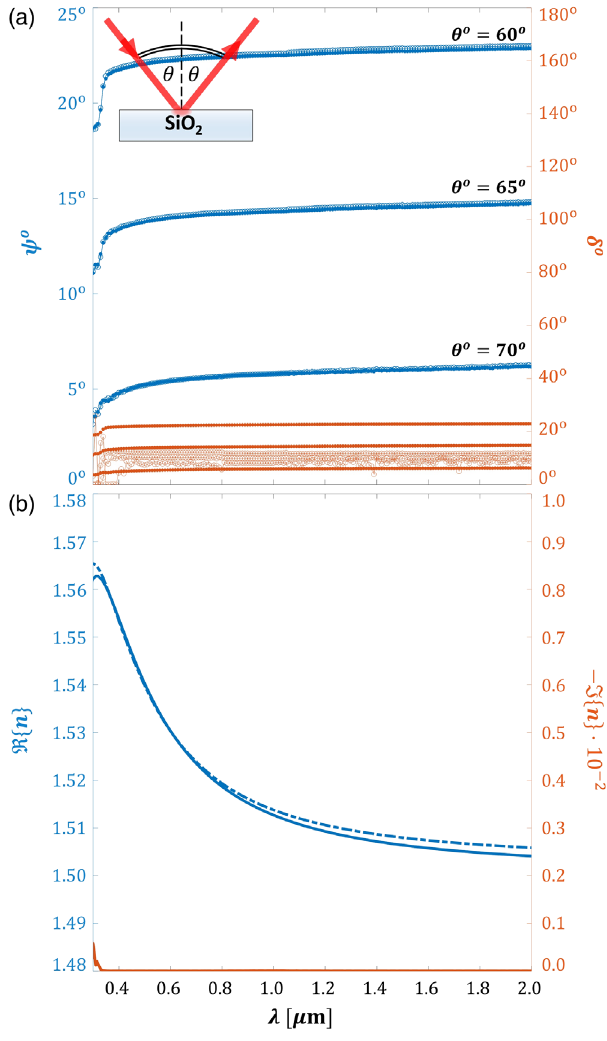
FIG. 5. Ellipsometry of chemically treated glass substrates. (a) Measured ellipsometry parameters ψ (blue, left axis) and δ (orange, right axis), for treated (hollow circles) and nontreated (dots) cover glass substrates as a function of illumination wave- length λ at three incidence angles θ (noted inset). (b) Real (blue, left axis) and imaginary (orange, right axis) parts of the refractive index n of the treated (dashed line) and nontreated (solid line) glass covers fitted from the measured data in (a). The change in n is smaller than 2 . 5 × 10 − 3 over the 300 nm – 2 μ m spectral